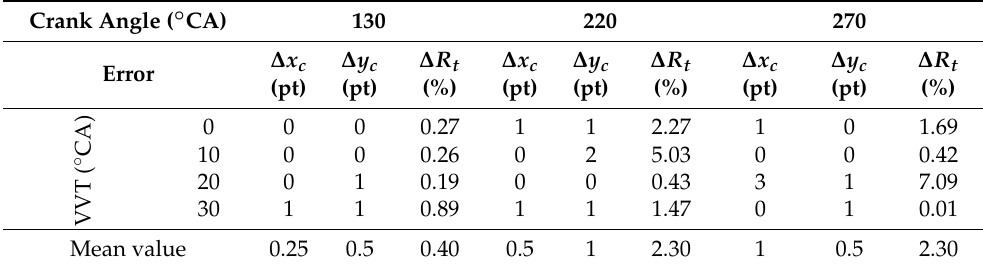
rates. The positional deviations of the center of rotation are expressed as the number of mesh points and those of the rotation rate in percent. We chose to do the calculations for three crank angles of the experimental plan. Table 2. Comparison between mean field and reconstructed field of points inside the POD database. Crank Angle ( ◦